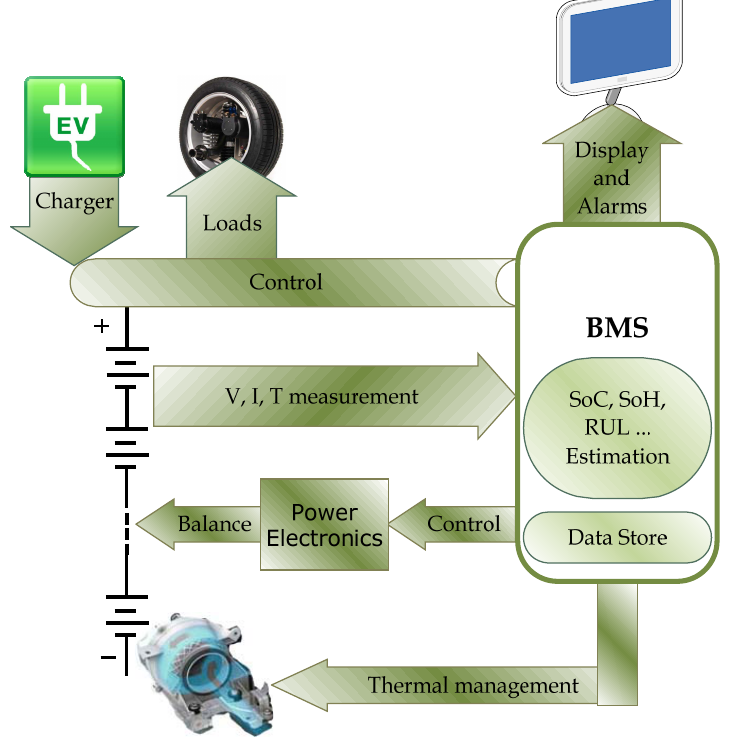
Figure 2. Overall architecture of a battery management system (BMS) [49]. SoC: state of charge; SoH: state of health; and RUL: remaining useful life. Reprinted/Reproduced with permission from 2013